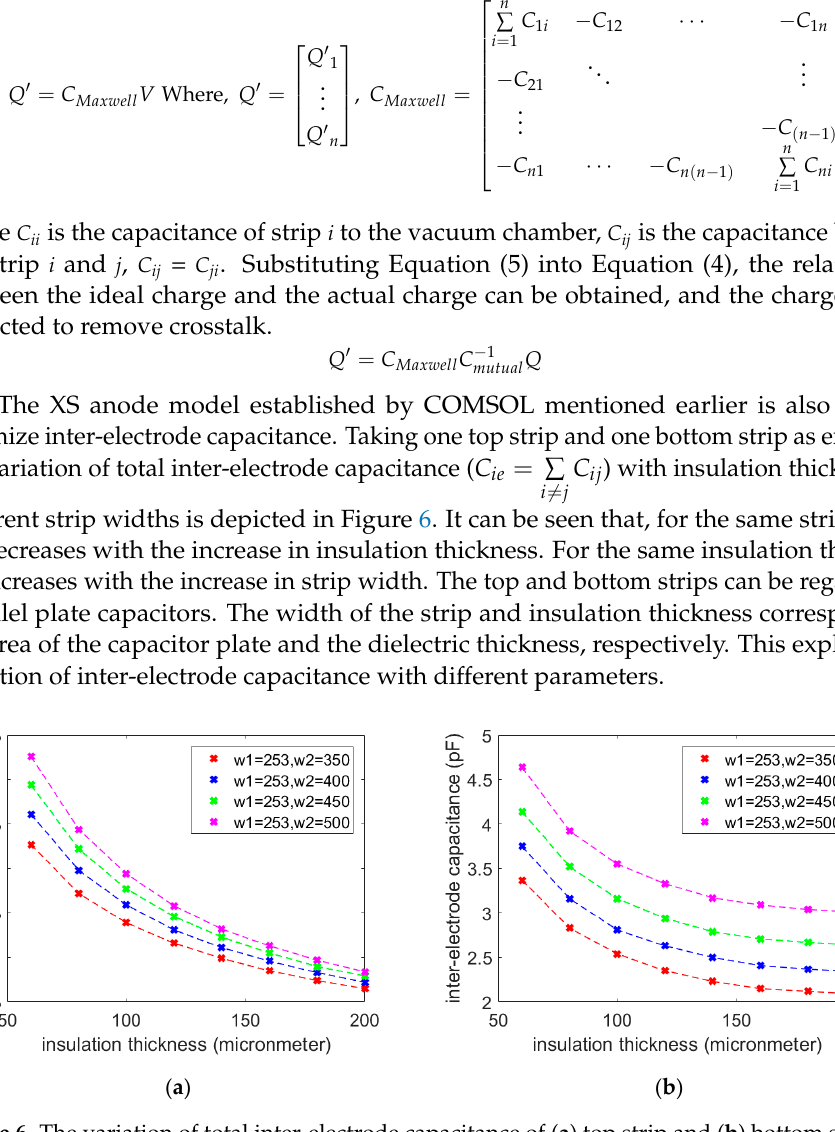
Figure 6. The variation of total inter-electrode capacitance of ( a ) top strip and ( b ) bottom strip with insulation thickness for different strip widths.